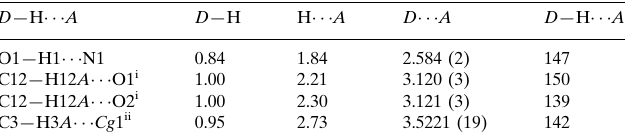
Hydrogen-bond geometry (A˚ , (cid:2)